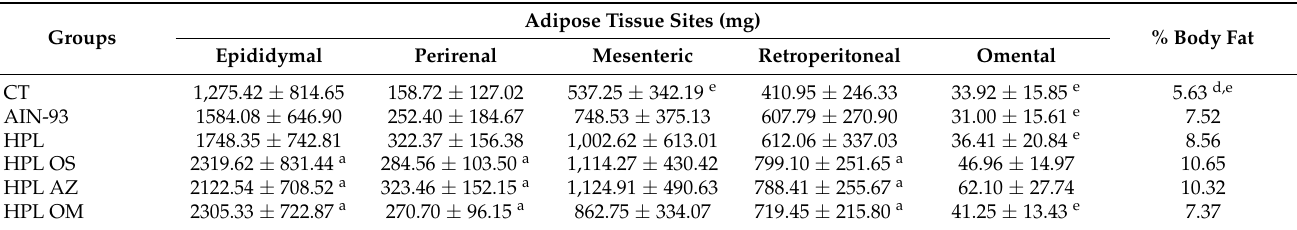
Table 3. Weight of adipose tissue sites and percentage of body fat of animals fed a balanced or high-fat diet and supplemented with saline, soybean oil, olive oil, or seed oil of papaya ( Carica pa- paya Linn).